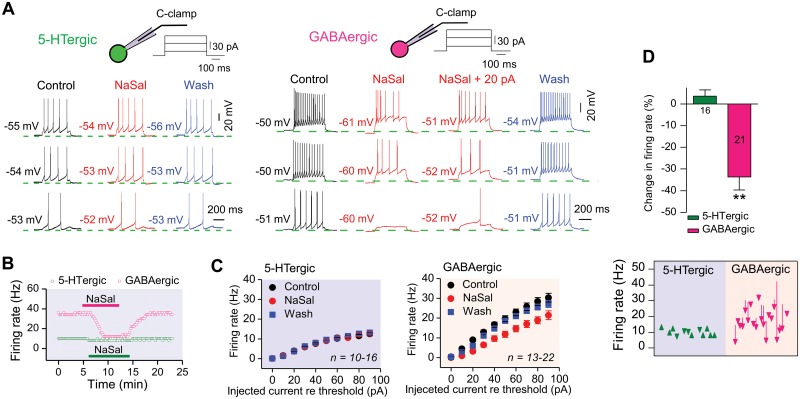
NaSal suppressed the current-evoked firing in GABAergic, but not in 5-HTergic, neurons of rat DRN.(A) Sample action potential trains in response to three depolarizing current steps (+20, 50, 80 pA; duration: 500 ms) in a 5-HTergic neuron and a GABAergic neuron following NaSal. The firing of the GABAergic neuron remained depressed by NaSal even its hyperpolarized membrane potential was adjusted back to the control level with a 20 pA current injection. RMPs indicated beside the traces. (B) Time courses of changes in firing rate of the same neurons in response to a +80 pA depolarizing current during NaSal application. (C) NaSal significantly suppressed input-output functions of current-evoked firing in GABAergic (P <0.01 relative to control, two-way RM-ANOVA), but not in 5-HTergic, neurons (P >0.05 relative to control, two-way RM-ANOVA). (D) Bar graph (upper panel) and trajectory plots (bottom panel) showing changes in firing rate of 5-HTergic and GABAergic neurons in response to a 60 pA depolarizing current re threshold following application of NaSal (two-way RM-ANOVA and one-way RM-ANOVA with Bonferroni correction). Sample sizes are indicated in inset. **P <0.01. Vertical line bars represent one standard error.